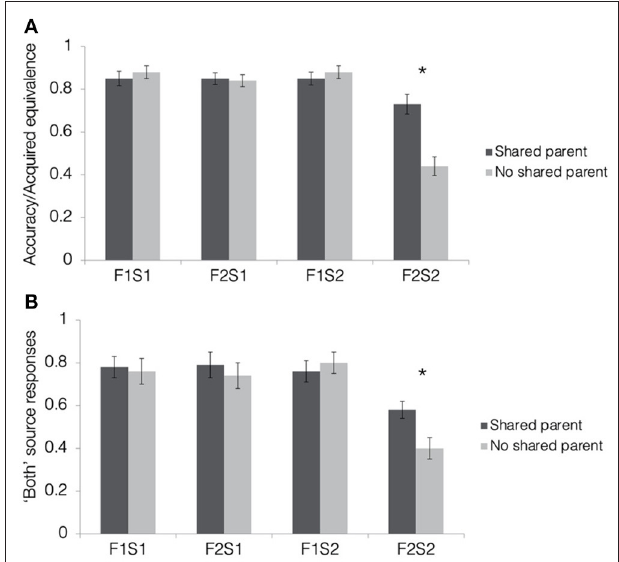
FIGURE 4 | Results from the tests of acquired equivalence and source memory in Experiment 1. (A) Acquired equivalence test accuracy for trained associations (F1-S1, F2-S1, and F1-S2) and rates of acquired equivalence for untrained associations (F2-S2). (B) For the source memory test, the proportion of trials where the participants responded that they had seen the items together during both study and test. This was the correct response for the trained associations but constituted a false memory for the untrained associations, since they were presented only during the test. All results are depicted separately for quadruplets with faces sharing a parent (dark gray bars) and quadruplets with faces not sharing a parent (light gray bars). Stars indicate a significant paired difference, following a significant test item type × quadruplet type interaction effect (corrected alpha = 0.0125).